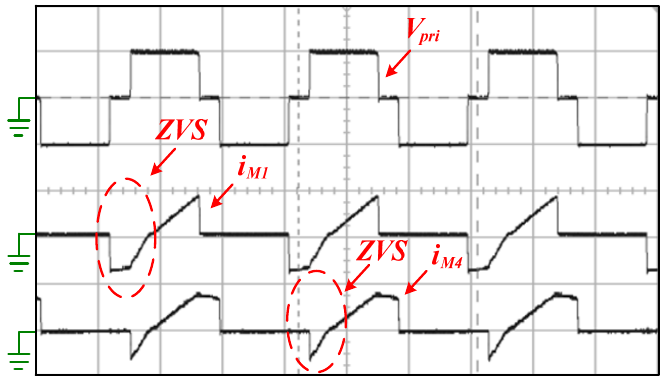
. V : 50 V/div; B LB